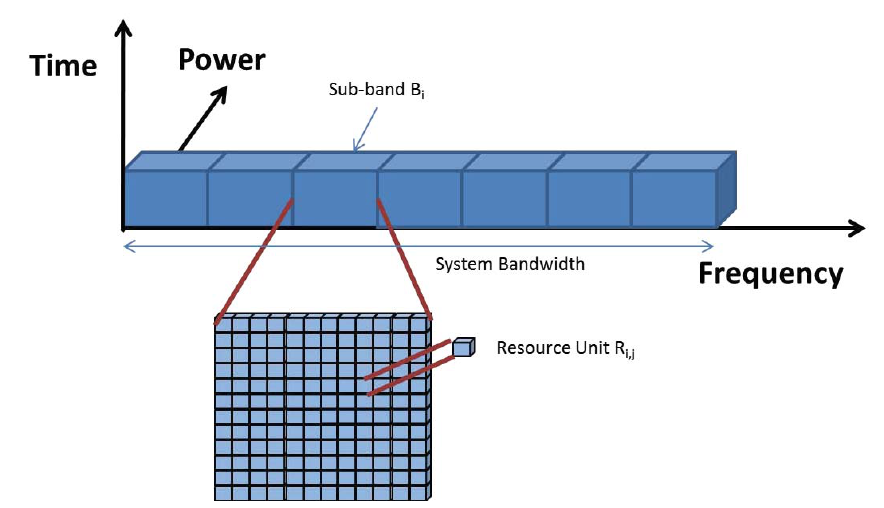
Figure 2. Spectrum